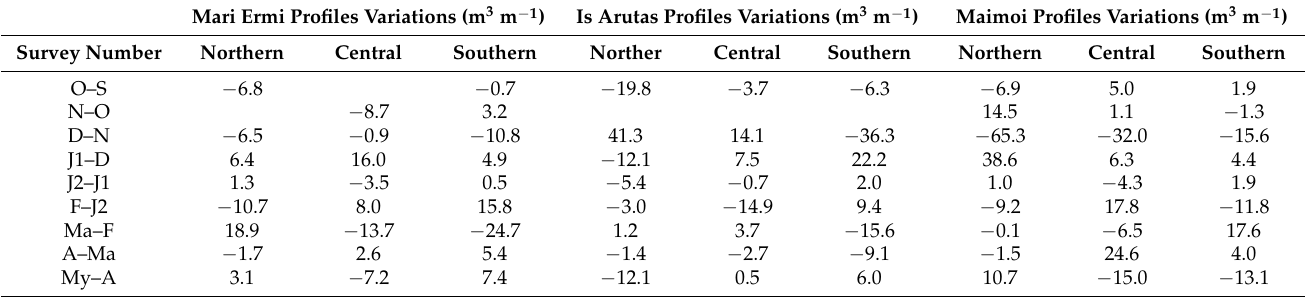
Table 2. The volumetric changes along the beach profiles during the date of the topographic survey. For cross correlation analyses, the second rows were not considered. The letters indicated the date of the topographic survey (see Table 1 caption). Mari Ermi Profiles Variations (m 3 m − 1